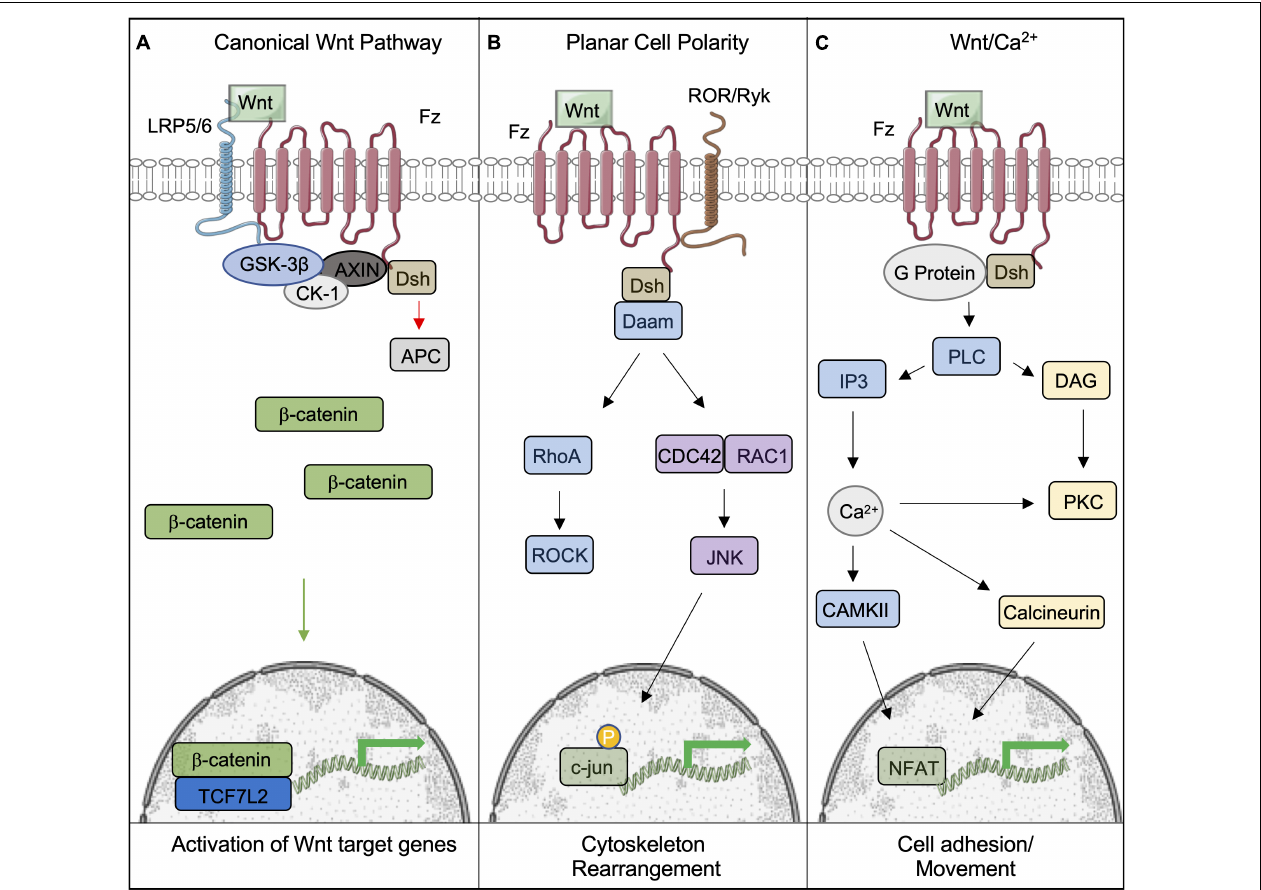
FIGURE 1 | Overview of the canonical and non-canonical Wnt signaling pathways. (A) Following binding of Wnt to the Frizzled-LRP5/6 complex and the activation of the signaling pathway, the destruction complex (comprising of GSK-3 β , CK-1, AXIN, and APC) is tethered to the plasma membrane, which permits β -catenin to accumulate and translocate to the nucleus, where it bind to TCF7L2 to activate downstream genes. (B,C) Wnts can also signal through non-canonical pathways to induce cell responses. (B) The Planar Cell Polarity pathway is activated upon Wnt binding to the Fz receptor. Dsh is subsequently activated, initiating the activites of Rho and Rac through Daam1. This leads to the eventual activation of ROCK and Jnk, which phosphorylates c-jun within the nucleus and allows it to initiate the transcription of target genes. (C) The Wnt/Ca 2 + pathways is also activated by Fz; however, it is coupled to a G-protein, leading to intracellular Ca 2 + release through PLC/IP3 activity. Ca 2 + promotes the activity of CAMKII and Calcineurin to provoke the accumulation of the transcription factor NFAT in the nucleus. This figure was made with modified images from Servier Medical Art (Creative Commons Attribution 3.0 Unported